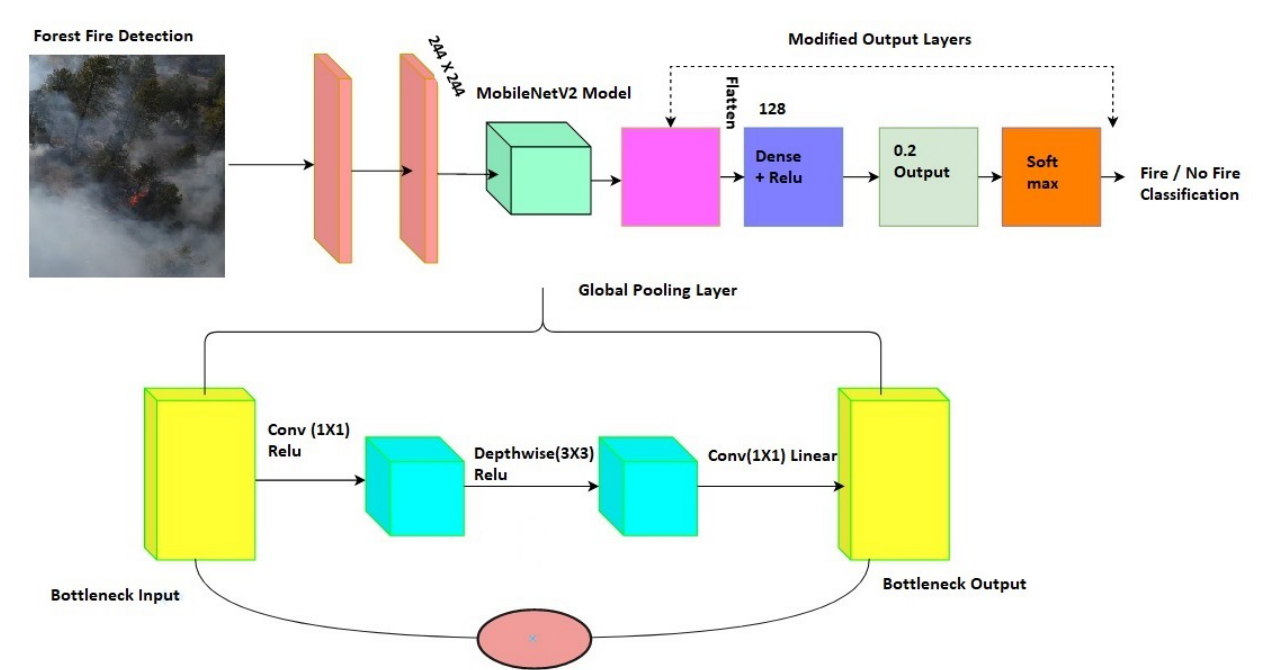
Figure 5. Workflow of extended MobileNet for forest fire